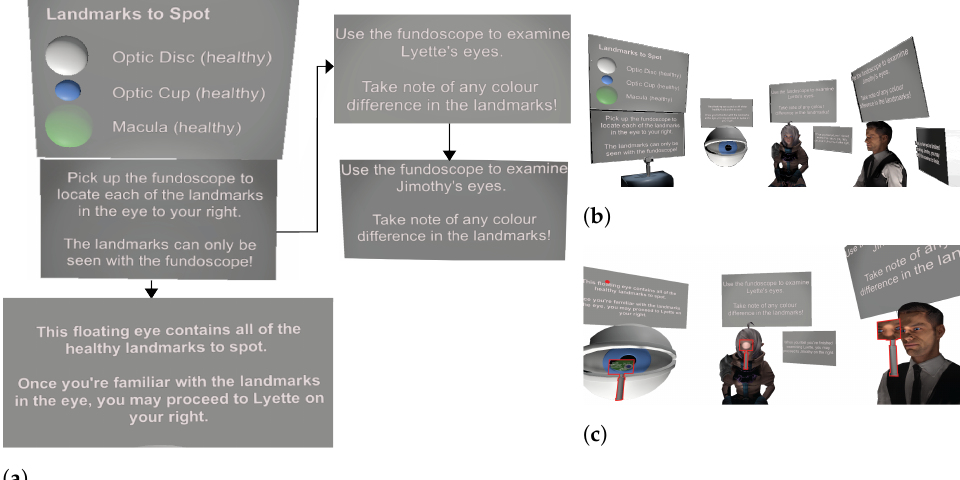
Figure 1. Virtual DO examination scenario update comparison. ( a ) Previous virtual scenario without the static ophthalmoscope add-on. ( b ) Tasks workflow. ( c ) Updated virtual scenario with static ophthalmoscopes for ease of fundus view in front of each virtual